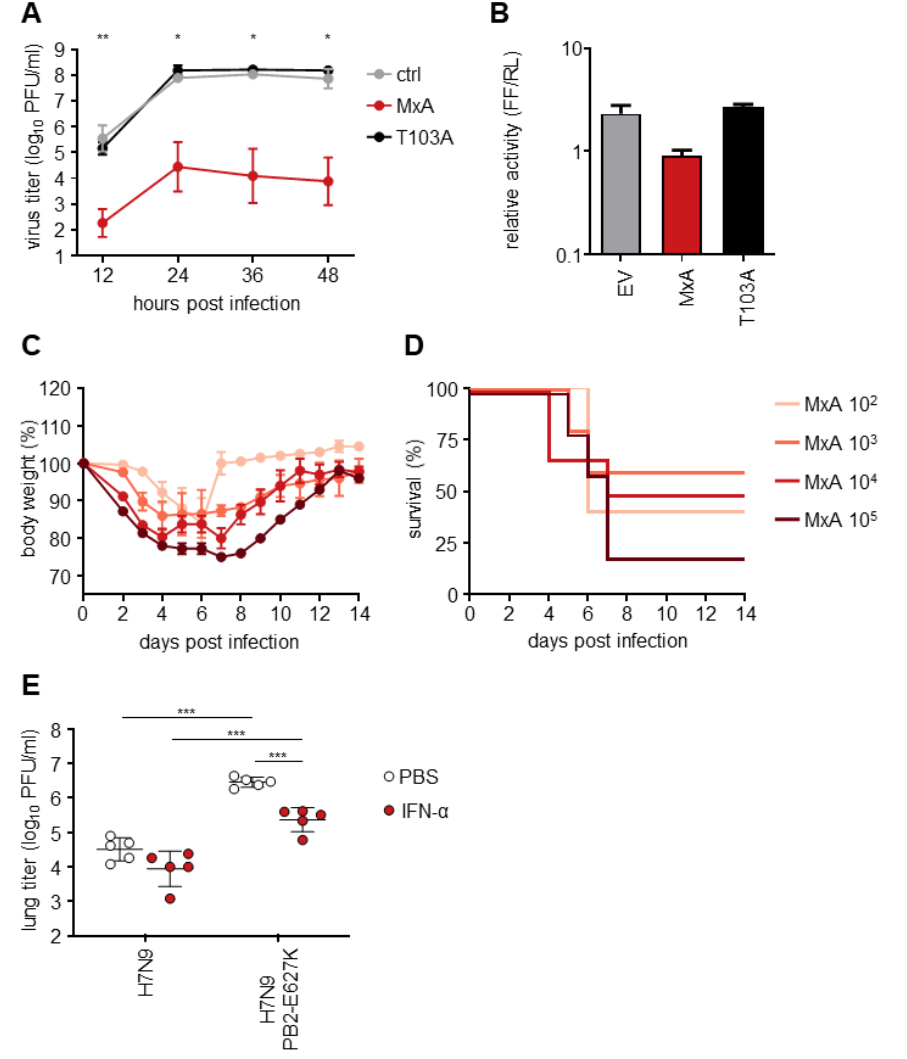
Figure 4. The PB2 E627K mutation enhances viral replication of HPAIV H7N9. ( A ) MDCK-SIAT1 cells (ctrl) and MDCK-SIAT1 cells either expressing antivirally active MxA or inactive MxA-T103A were infected with H7N9 at an MOI of 0.001. Viral titers were determined at the indicated time points via plaque assay. Significance levels indicate differences between MDCK-SIAT1-MxA and -MxA-T103A cells. ( B ) Viral polymerase reconstitution assay were performed as described in the legend to Figure 1B using a plasmid encoding PB2-E627K instead of wildtype PB2. ( C , D ) MxA tg/tg mice (MxA) were infected intranasally with the indicated doses of H7N9-PB2-E627K in 40 µ L